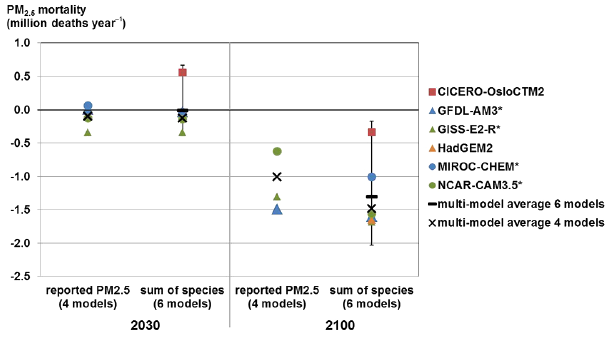
Figure 7. Estimates of global future premature mortality (IHD + STROKE + COPD + LC) for RCP8.5 in 2030 and 2100, for PM 2 . 5 reported by four models and PM 2 . 5 estimated as a sum of species for six models, showing global mortality for each model and the multi-model average (milliondeathsyear − 1 ), for future air pol- lutant concentrations relative to 2000 concentrations. Models sig- naled with * reported their own estimate of PM 2 . 5 . Uncertainty shown for six models for sum of species is the 95% CI including uncertainty in RR and across models.